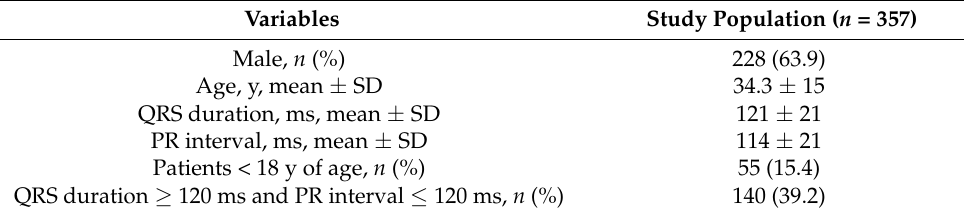
Table 1. Baseline characteristics of the study